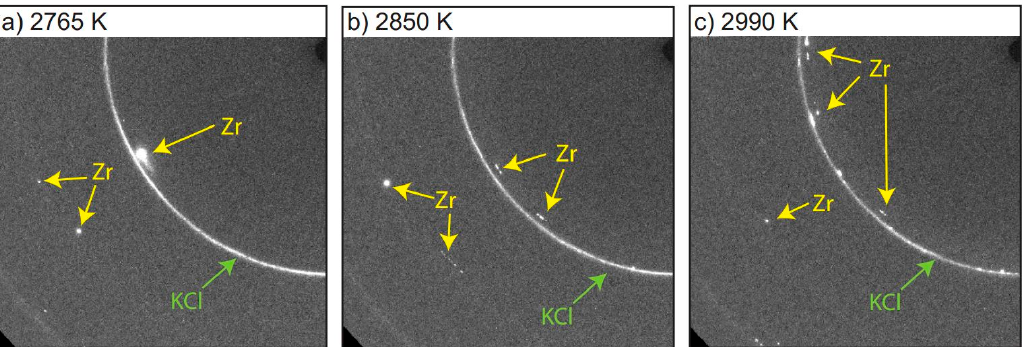
Figure 8. XRD 2D images of a Zr sample at different temperatures (P = 49 GPa) [37]. The movement of polycrystalline spots with temperature is related to movements in the sample surface. The actual melting temperature at this pressure point is 3235 K.